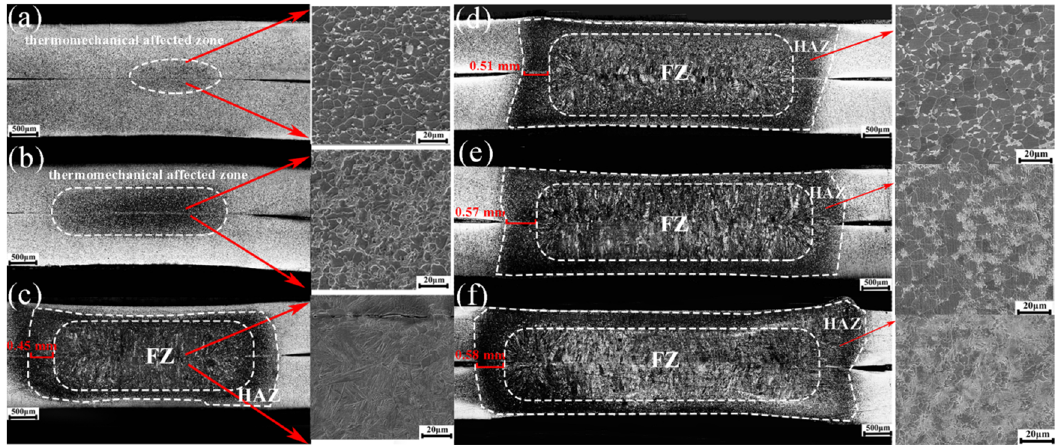
Figure 4: Macro photographs of the resistance spot welded joints in di ff erent con fi gurations: ( a ) one cycle, ( b ) two cycles, ( c ) four cycles, ( d ) six cycles, ( e ) eight cycles and ( f ) ten